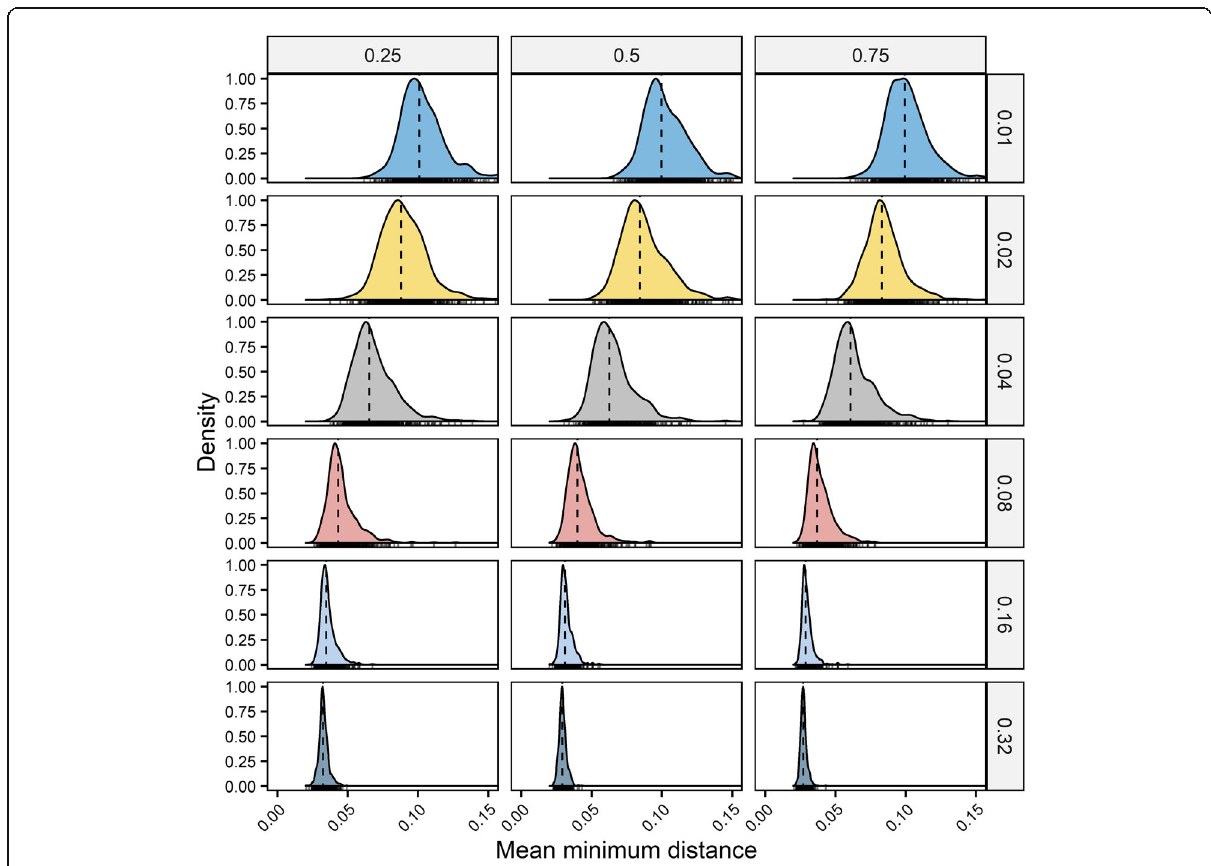
Fig. 4 The density of BCA abundance in a given simulation run for each combination of biocontrol aggregation (0.01, 0.02, 0.04, 0.08, 0.16, 0.32) and patchiness (0.25, 0.50, 0.75) in a heterogeneous simulation area with a small grain size. For all simulations, the initial abundance for the BCA was 400, some of which may be discarded when they were in the patches favouring the pathogen. The dashed line indicates the median